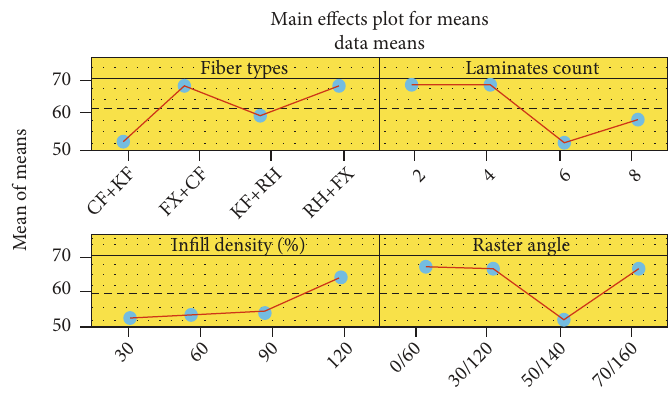
Figure 11: Main e ff ect plot for means (shore hardness).